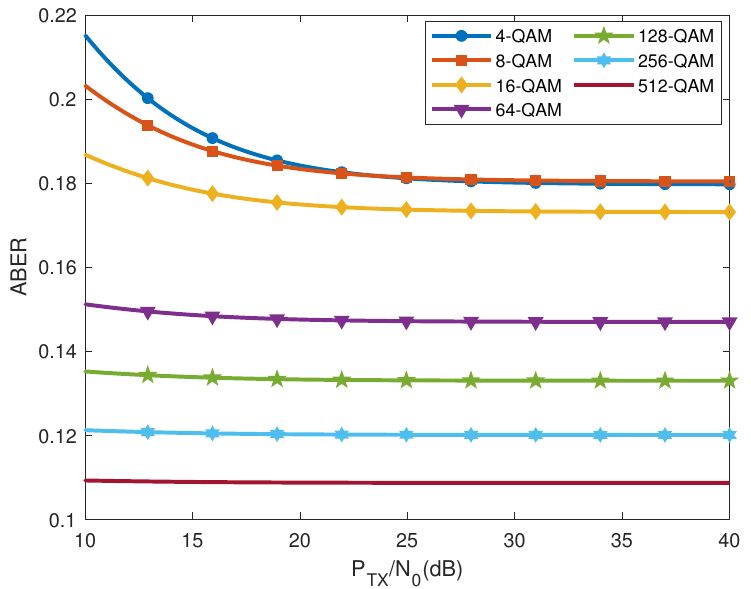
Figure 7. The bandwidth limited ABER of POV carrier link with M-QAM versus the SNR of optical system P TX / N 0